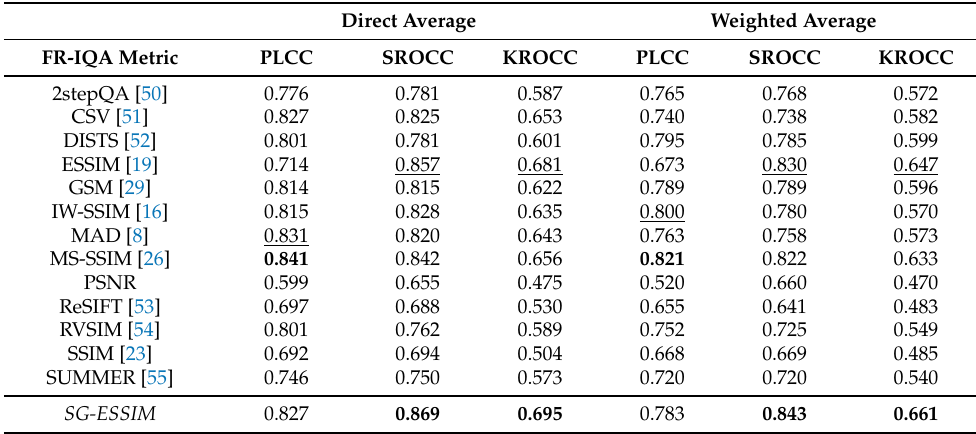
Table 5. Comparison of SG-ESSIM to several other state-of-the-art algorithms. Direct and weighted average PLCC, SROCC, and KROCC values are presented. Measured on KADID-10k [20], TID2013 [7], TID2008 [21], and CSIQ [8]. The highest values are typed in bold , while the second highest ones are